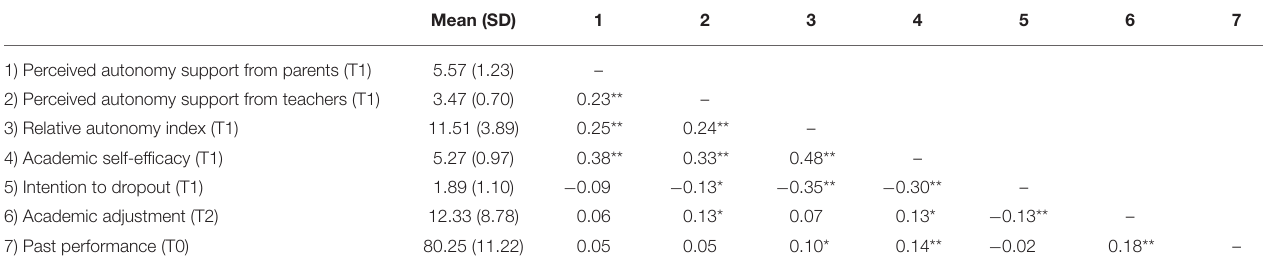
TABLE 2 | Descriptive statistics and zero-order correlations of the key variables of the study measured at Time 1, the academic adjustment recorded at Time 2 and the past performance at Time